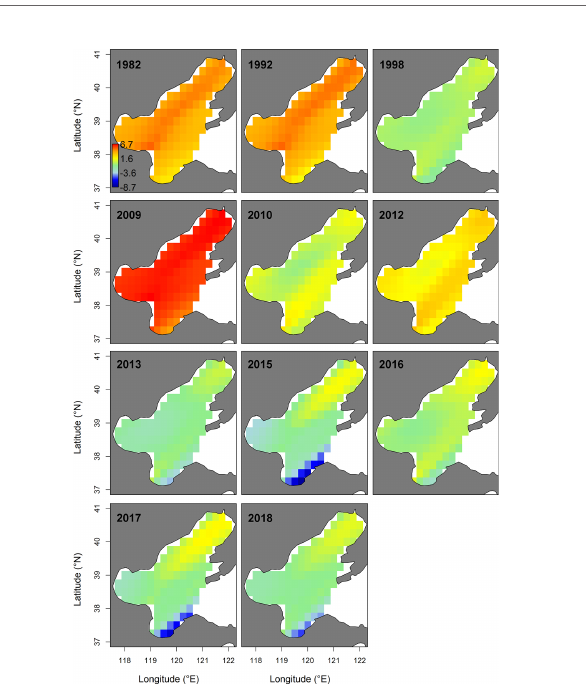
FIGURE 4 | Spatio-temporal distribution of log-density for the stock of the Bohai Sea in summer of 1982 − 2018, predicted by the AIC-selected model. The color legend with units ln(kg.km -2 ) is provided in the fi rst panel. Only projections for the years where sampling for the stock were available